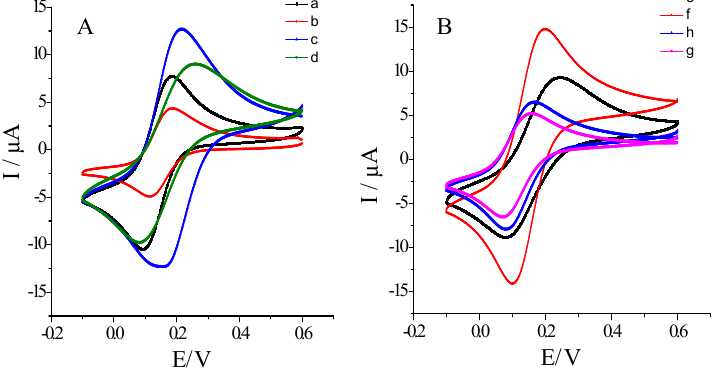
Figure 4. Assembly process of cyclic voltammetry curve of hFc γ Rn electrochemical receptor sensor.